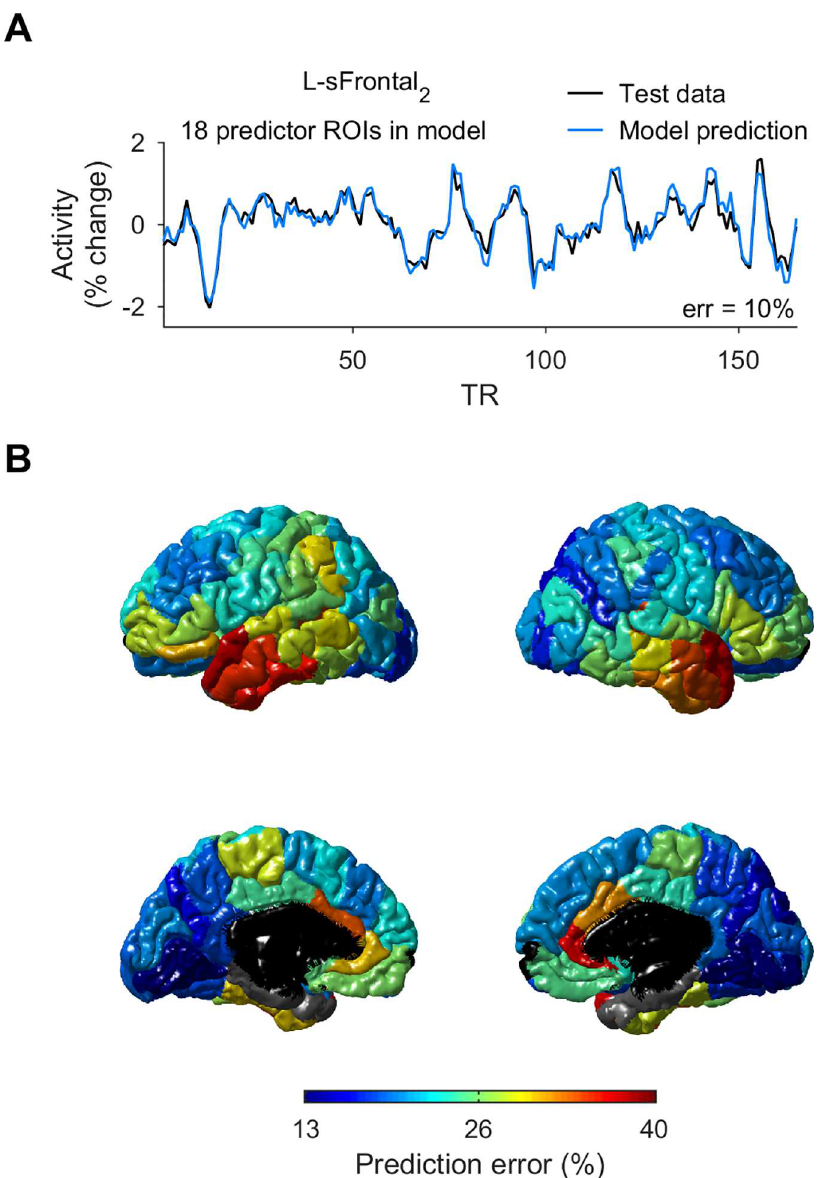
Fig 3. Model prediction error across ROIs. A. Observed activity (black) of left superior frontal gyrus 2 (the second-most anterior ROI in left superior frontal gyrus, see Methods)of an examplesubject, and predicted activity of a model using 18 predictor ROIs selectedby RFE (blue). B. Lateral and medialviews of both hemispheres, showingthe averageprediction error in cortical ROIs (n = 46 subjects).